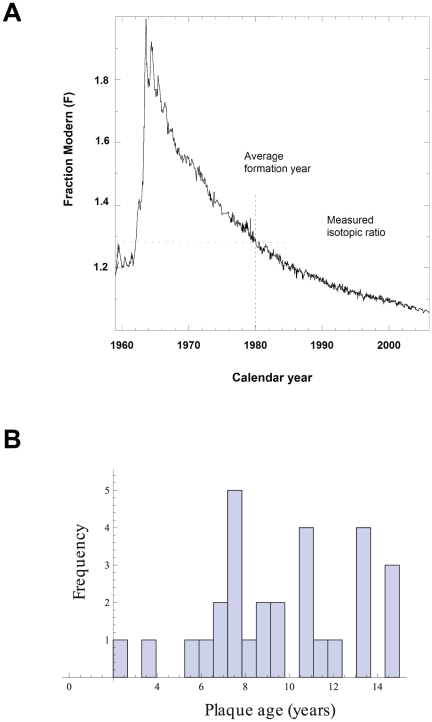
The bomb curve and histogram of the carotid plaque age
distribution.(A) The bomb curve. Carotid plaque samples were
14C dated using AMS. The cellular birth dates can be
inferred by determining the time at which 14C concentration
of the sample corresponded to the atmospheric concentration, using the
Levin data as reference bomb curve. (B) Plaque age
distribution in all carotid stenosis patients
(n = 29). The interval is from 2–14 years,
and all but two patients had plaque ages within a 10-year interval.